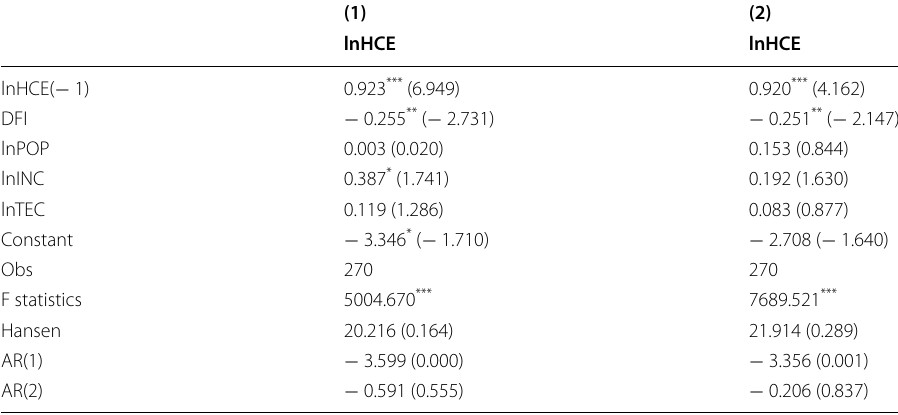
The values in parentheses represent the t-statistics * , ** , *** imply the significance at the 10%, 5%, and 1% levels,